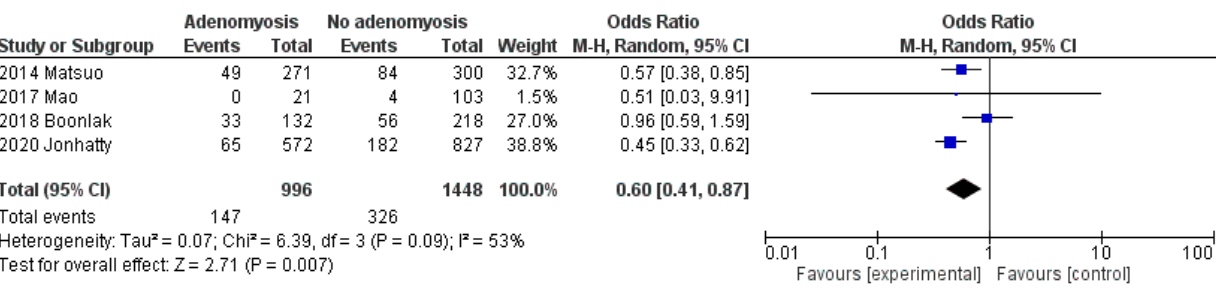
Figure 4. Forest plot of odds ratio for nulliparity in endometrial cancer patients with adenomyosis compared to endometrial cancer patients without adenomyosis, for each included study and as pooled estimate.